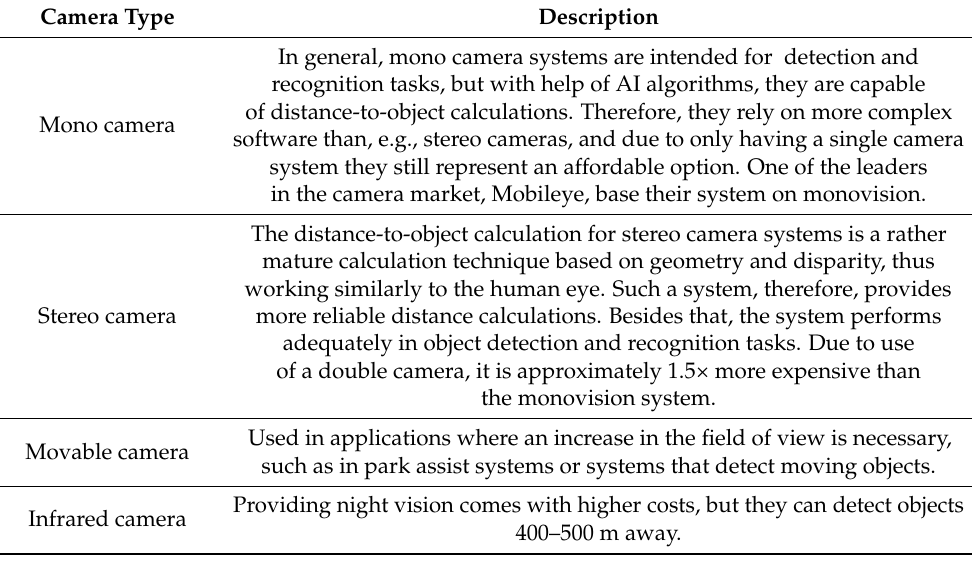
Table 1. Camera types used in